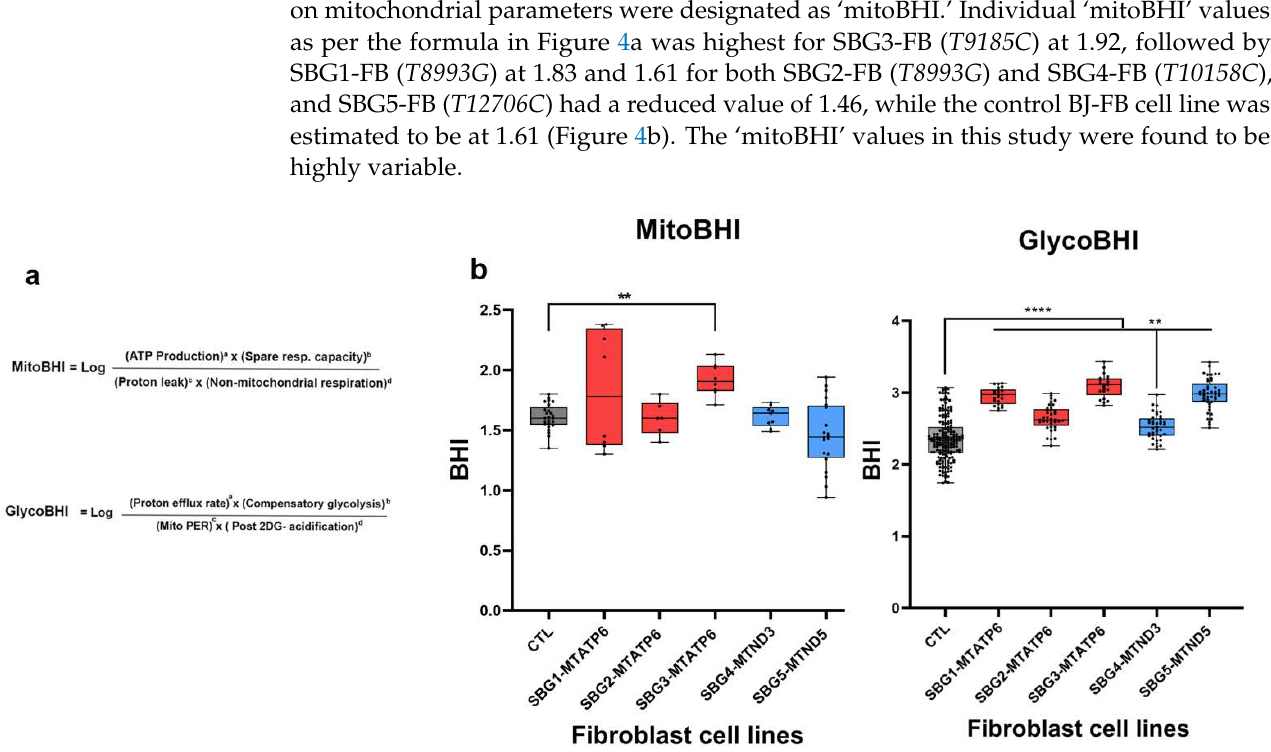
Figure 4. Composite Bioenergetic Health Index (BHI) ratio for BJ-FB and five LS fibroblast cell lines. The LS lines are SBG1-FB ( MT-ATP6-T8993G ), SBG2-FB ( MT-ATP6-T8993G ), SBG3-FB ( MT-ATP6-T9185C ), SBG4-FB ( MT-ND3-T10158C ), and SBG5-FB ( MT-ND5-T12706C ) impacting the function of ATP synthase or NADH dehydrogenase. ( a ) The formula used to calculate the MitoBHI and GlycoBHI ( b ) Mito-BHI values were quantitated based on four bioenergetic parameters: mitoATP production, spare reserve capacity, proton leak and non-mitochondrial respiration. Glyco-BHI values were quantitated based on four glycolytic parameters: Basal glycolysis (Basal PER), compensatory glycolysis, mitochondrial acidification (MitoPER), and post 2-DG acidification. ** p < 0.01 **** p <